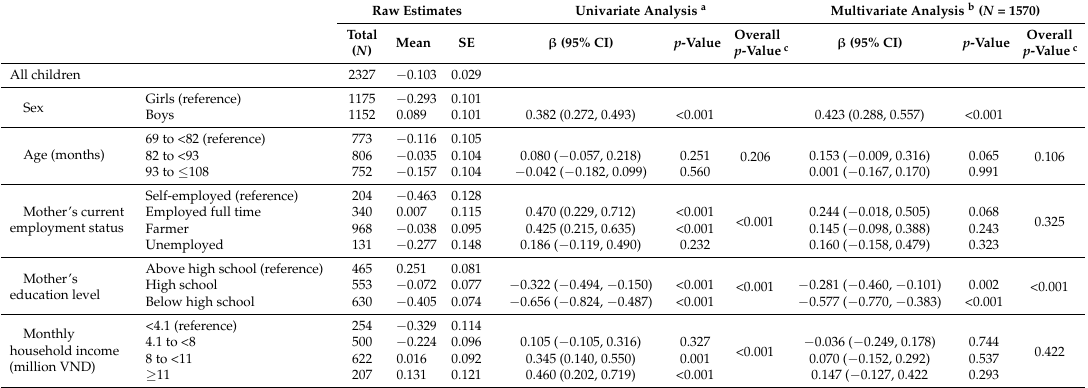
Table 7. BMI-for-age z -scores and associated sociodemographic factors in 6–9-year-old children in rural areas of Vietnam.